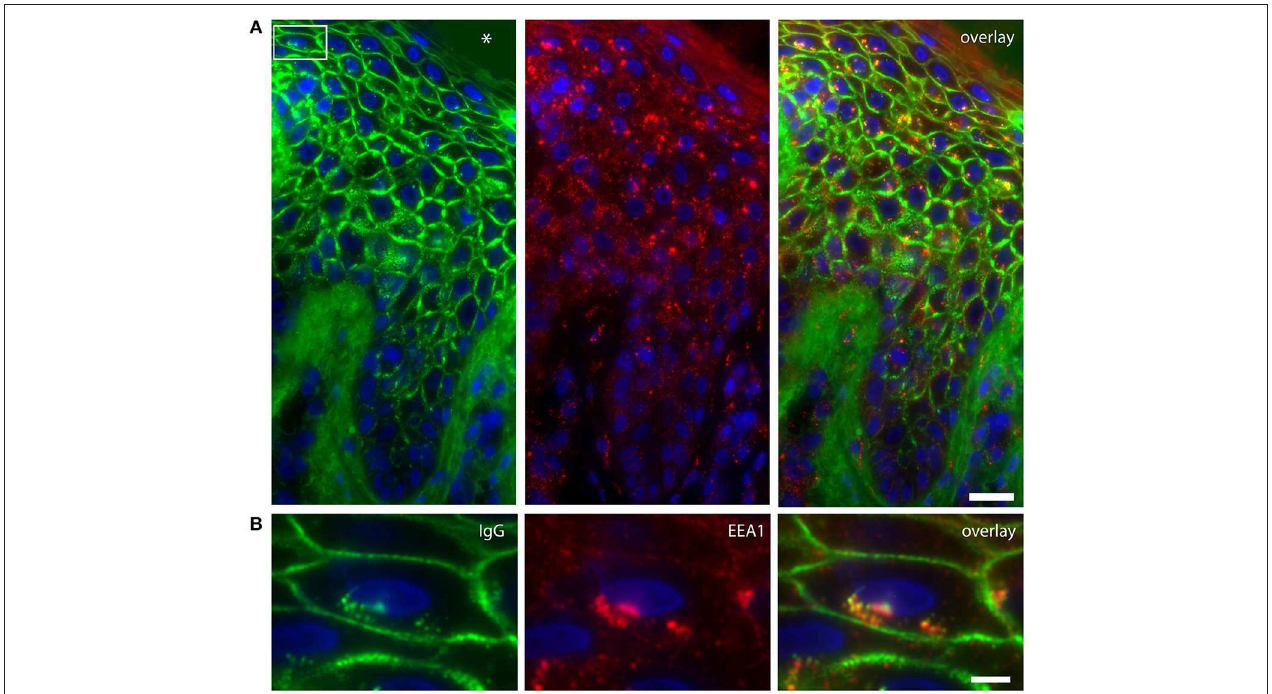
FIGURE 1 | Colocalization of IgG and endosomes in lesional PF patient skin. (A) IgG (green) and EEA1 (red) colocalize in the higher skin layers (right panel). The white box depicts the cell shown in (B) . The blister cavity is indicated by an asterix. White bar: 25 µ m. (B) Detail showing the perinuclear localization of IgG. White bar: 5 µ